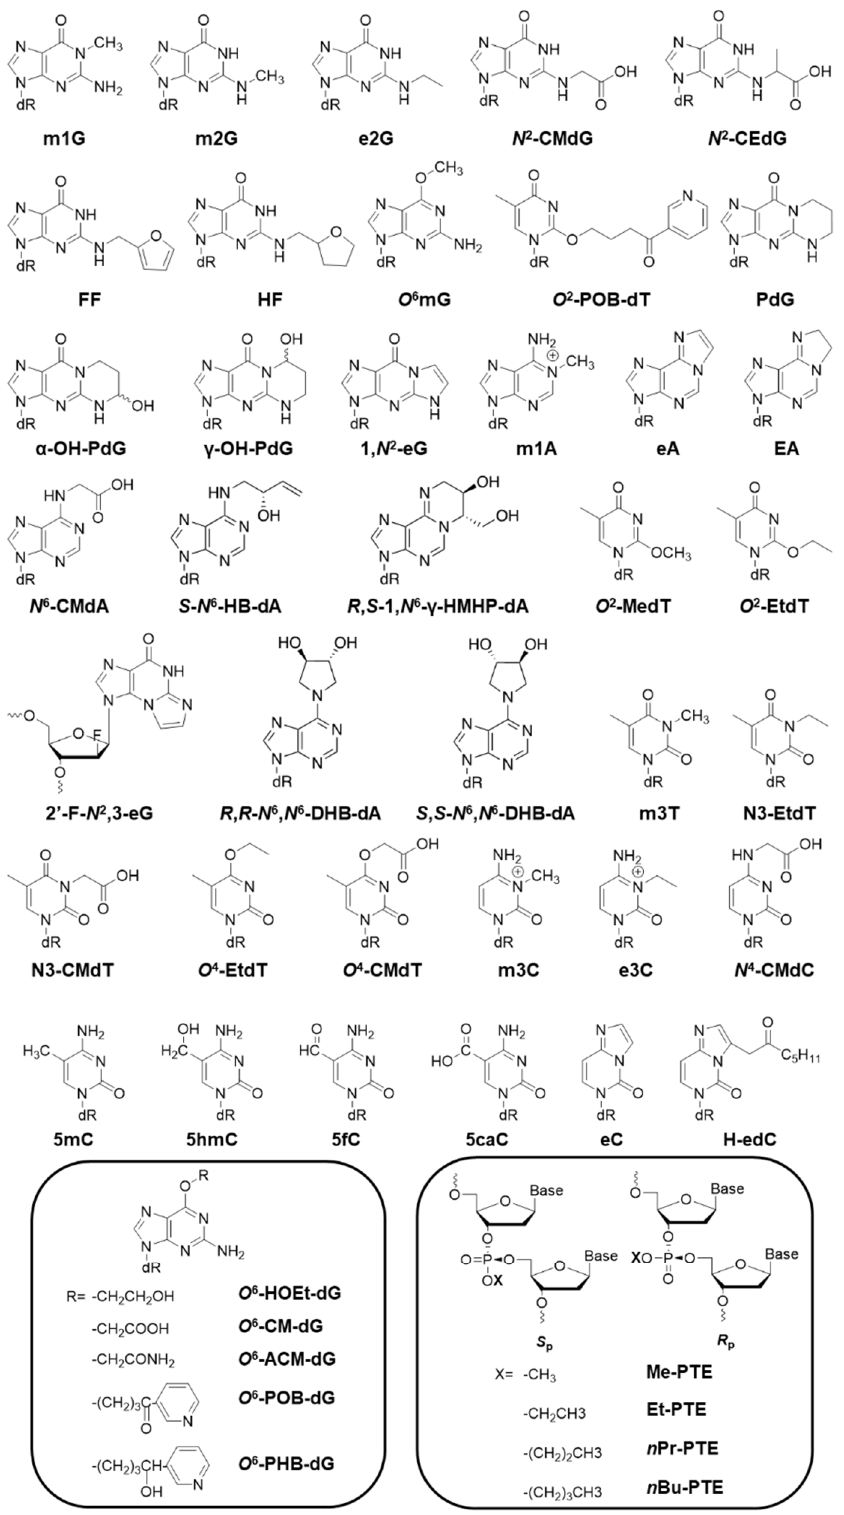
Figure 3. Structures of alkyl modifications. Cont.